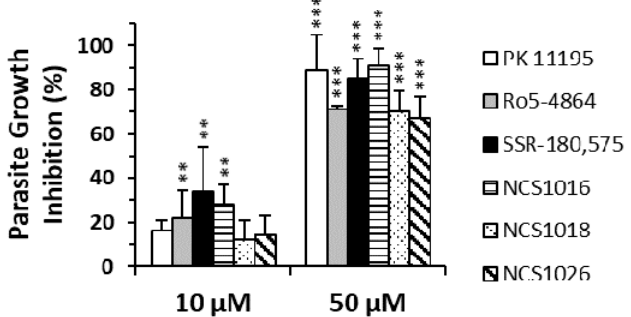
Figure 1. TSPO ligands inhibited the P. falciparum growth. Infected RBCs were diluted to 1% parasitemia, and maintained at 1 – 5%, by dilution, for 48 h. Percentages of growth-inhibition were obtained, after two parasite cycles, by the flow cytometry analysis of parasitemia, and normalized to the control condition (solvent-treated cells). Data are presented as the mean ± SEM; N = 4. Differences between the control condition and the treatment were considered significant at ** p < 0.01; *** p < 001.